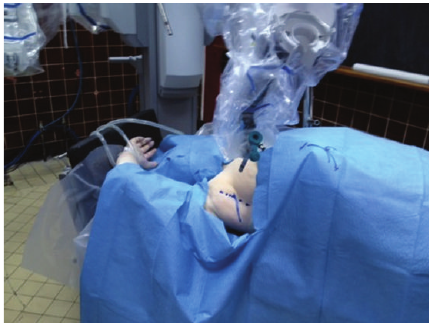
Figure 3: The picture showing the setup position of the robot.